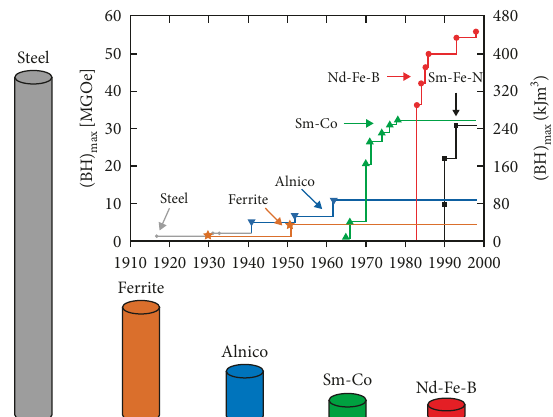
Figure 1: A schematic representation of the development cycle for permanent magnetic materials and a representation of different types of materials with comparable energy densities [17].